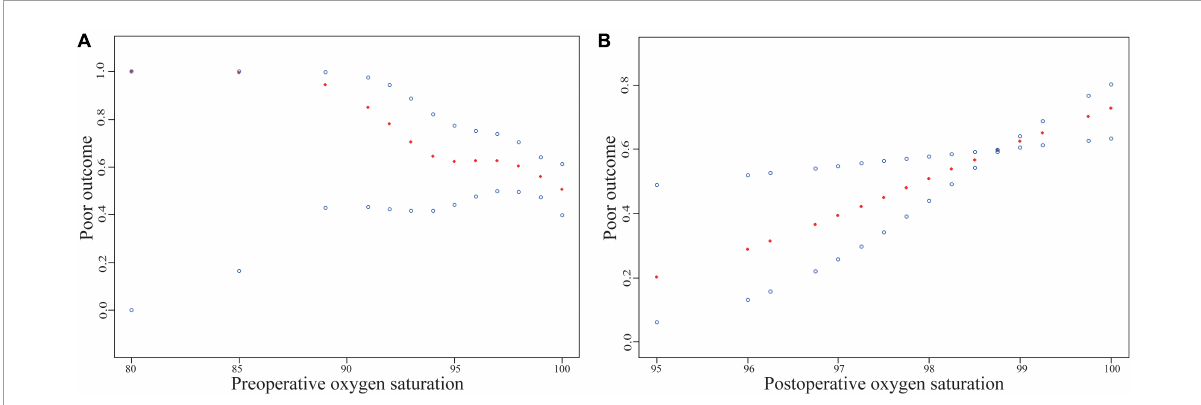
FIGURE1 Relationship between preoperative/postoperative oxygen saturation and functional outcomes of ischemic stroke. The red dots in the middle of the figure represent the smooth curve fit, and the blue dots represent the 95% confidence interval of the fit. The scatter plot of curve fit results mainly reflects the probability of 3-month poor outcome (Y-axis) with different oxygen saturation levels (X-axis). Adjusted for variables that were significantly associated with poor outcome ( P < 0.10) or changed the estimates of oxygen saturation on poor outcome by more than